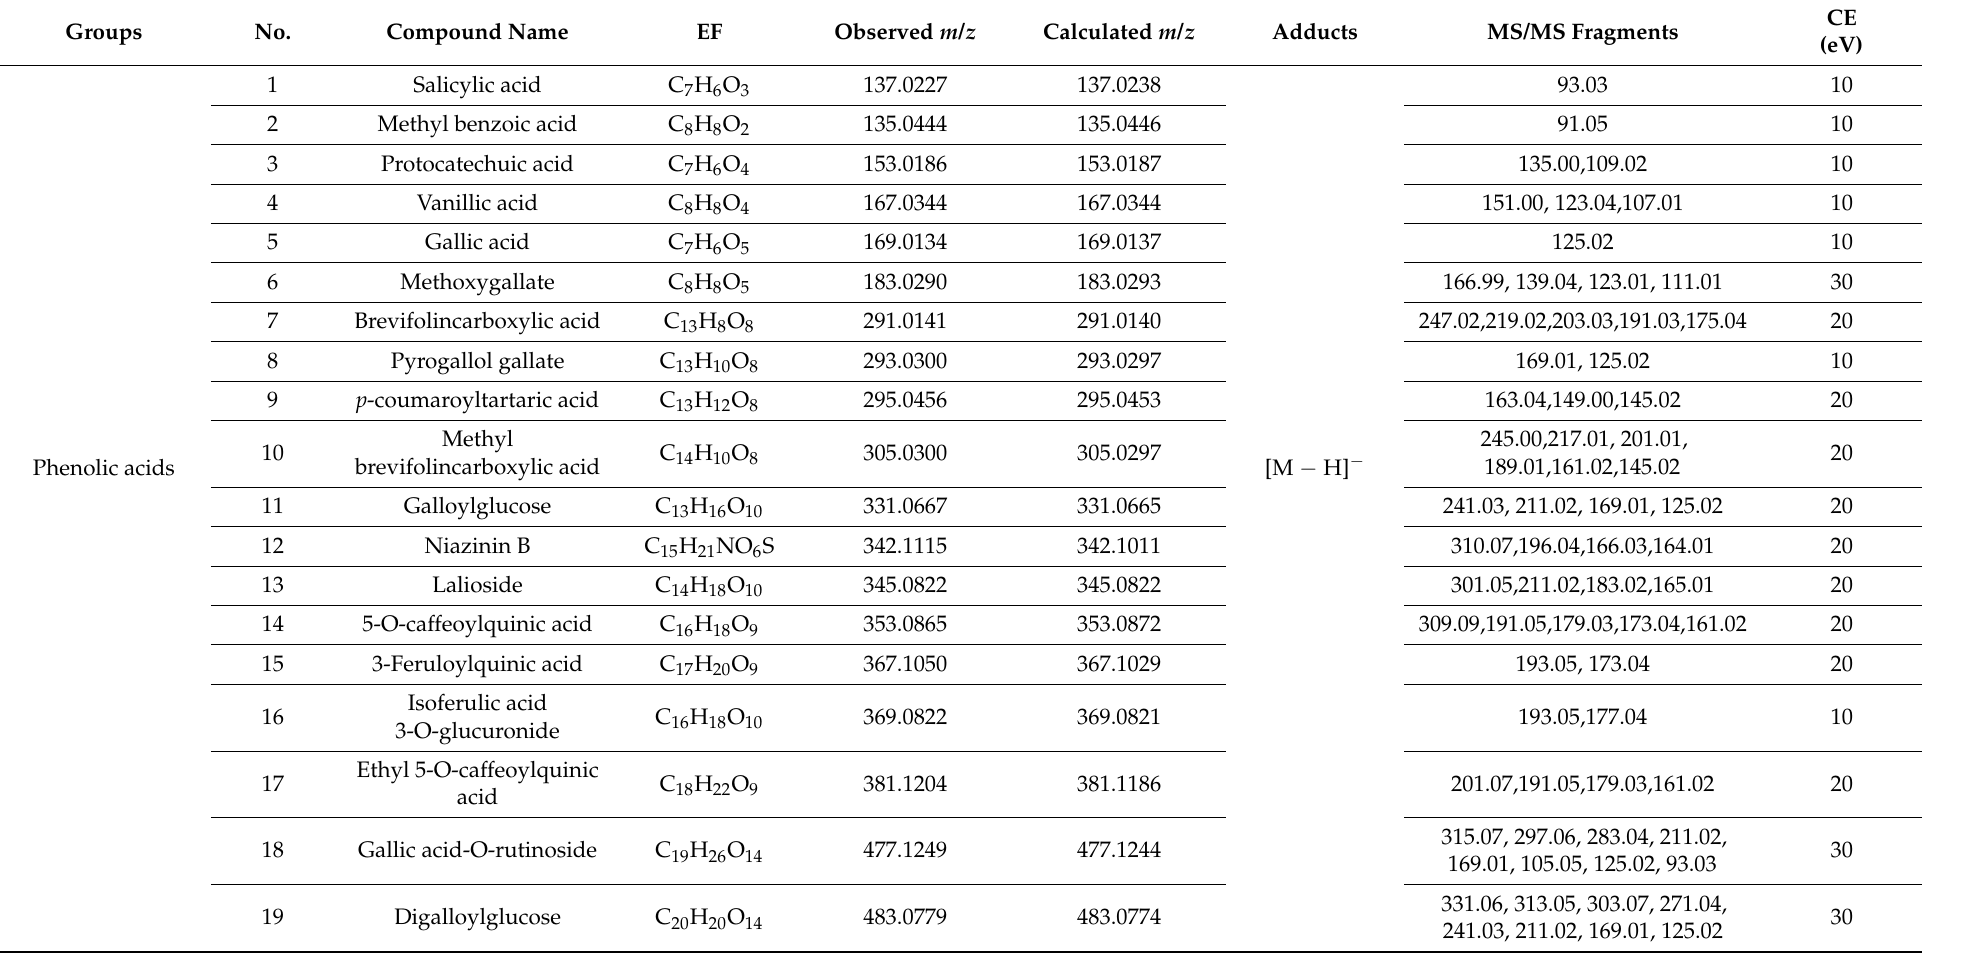
Table 1. Secondary metabolites identified in Nympheae nouchali stem using negative-mode electrospray ionization mass spectrometry (ESI-MS/MS).